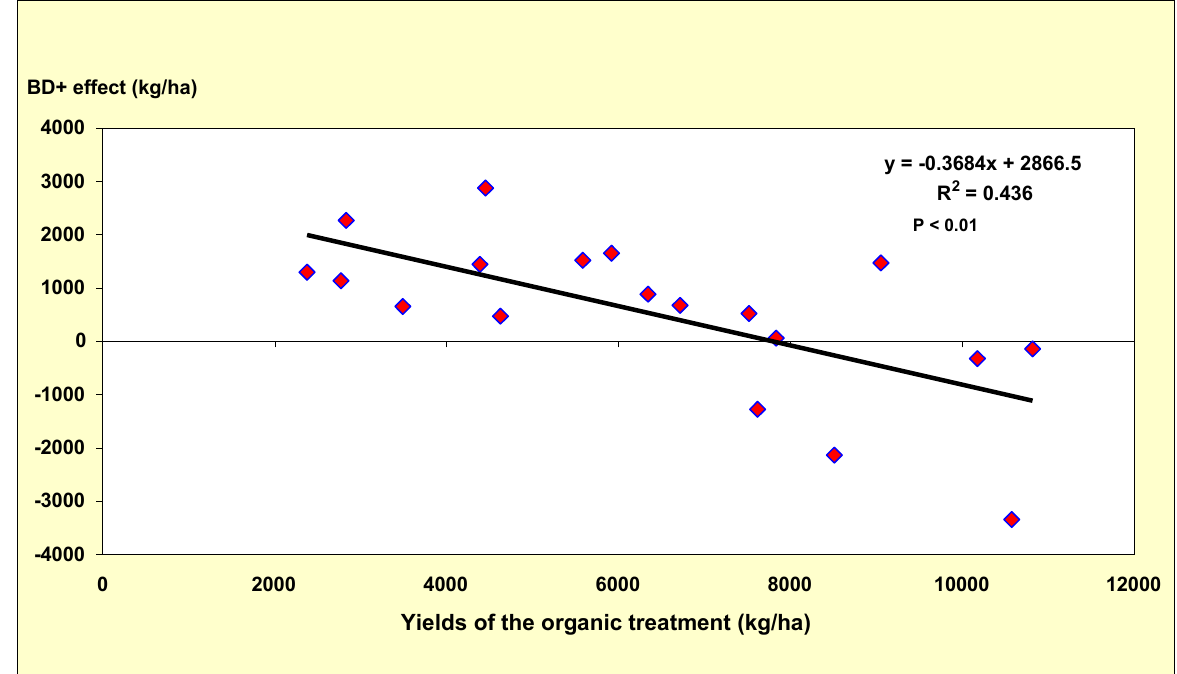
Figure 3: Effects of different management systems on the yields of maize var. Golden Eagle